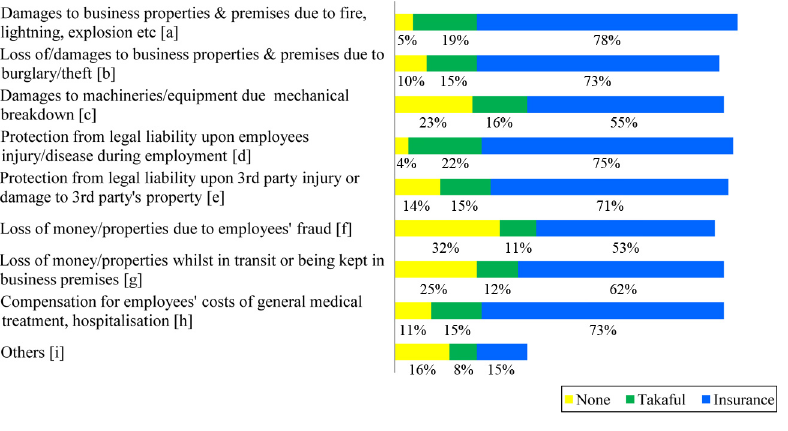
Figure 11. Composition of respondents ’ subscriptions to tak (cid:1) aful vis-à-vis insurance coverage according to the risk